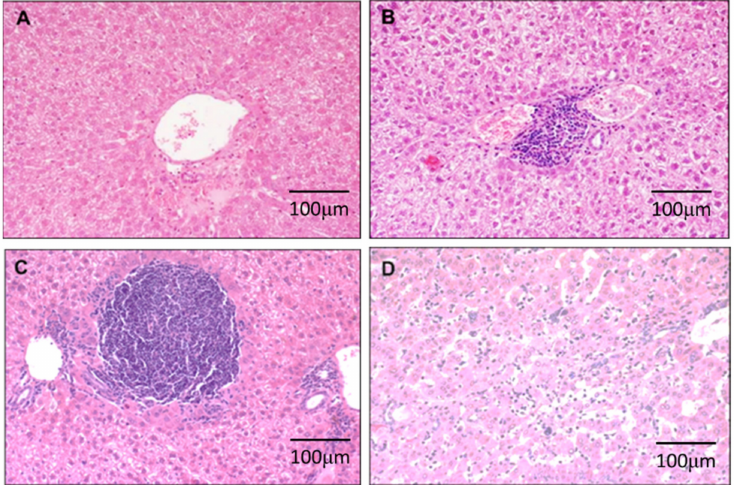
Figure 1. H&E staining of hamster liver: Portal inflammation was scored from 0 to 3 in week 7 ( n = 5), 27 ( n = 8), 33 ( n = 8), 50 ( n = 12) where a score of 0 indicated no portal inflammation ( A ); a score of 1 indicated ≤ 2 portal inflammation ( B ); a score of 2 indicated >2 portal inflammation ( C ); and a score of 3 indicated portal inflammation with interstitial sinusoidal inflammation ( D ).